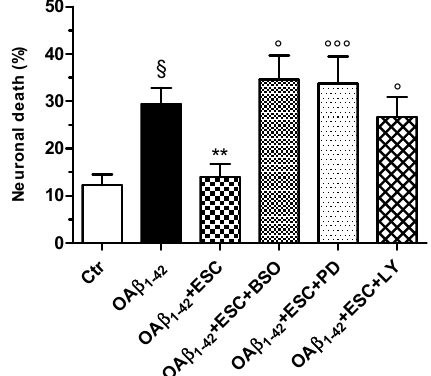
Figure 8. Neuroprotective effects of ESC are abrogated by the specific inhibitors BSO, PD98059 and LY294002 in SH-SY5Y cells. Cells were treated with ESC (20 µ M) and the specific inhibitors BSO (400 µ M), PD98059 (5 µ M) and LY294002 (10 µ M) for 24 h. Subsequently, cells were treated with OA β 1–42 (10 µ M) for 24 h. At the end of treatment, the neuronal death was determined using the fluorescent probe PI. Data are expressed as percentage of dead cells and reported as mean ± SD of four independent experiments ( § p < 0.05 vs. untreated cells; ** p < 0.01 vs. cells treated with OA β 1–42 ; ◦ p < 0.05 and ◦◦◦ p < 0.001 vs. cells treated with OA β + ESC at one-way ANOVA with Bonferroni 1–42 post-hoc